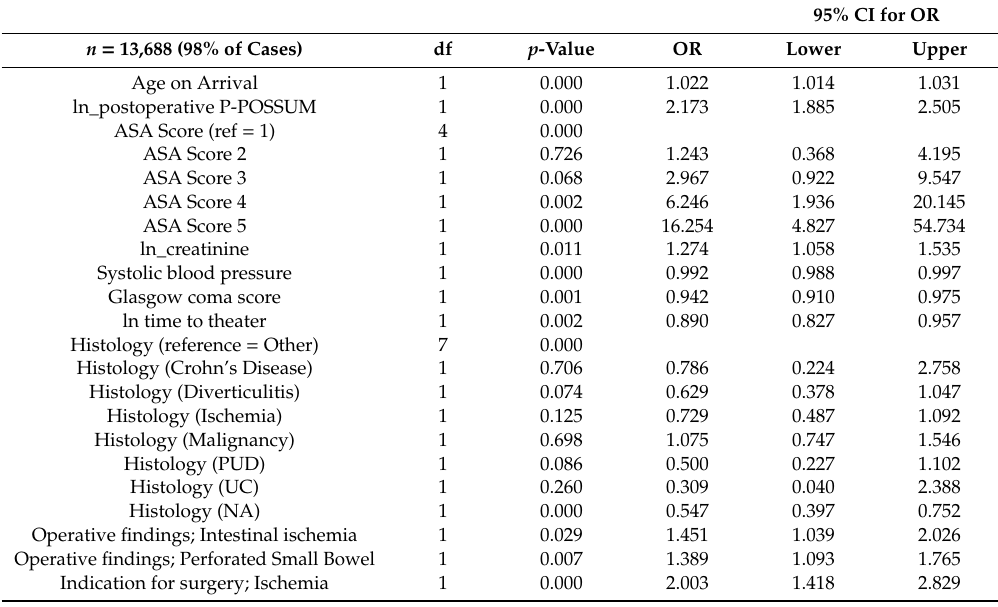
Table A1. Multivariate analysis (following stepwise